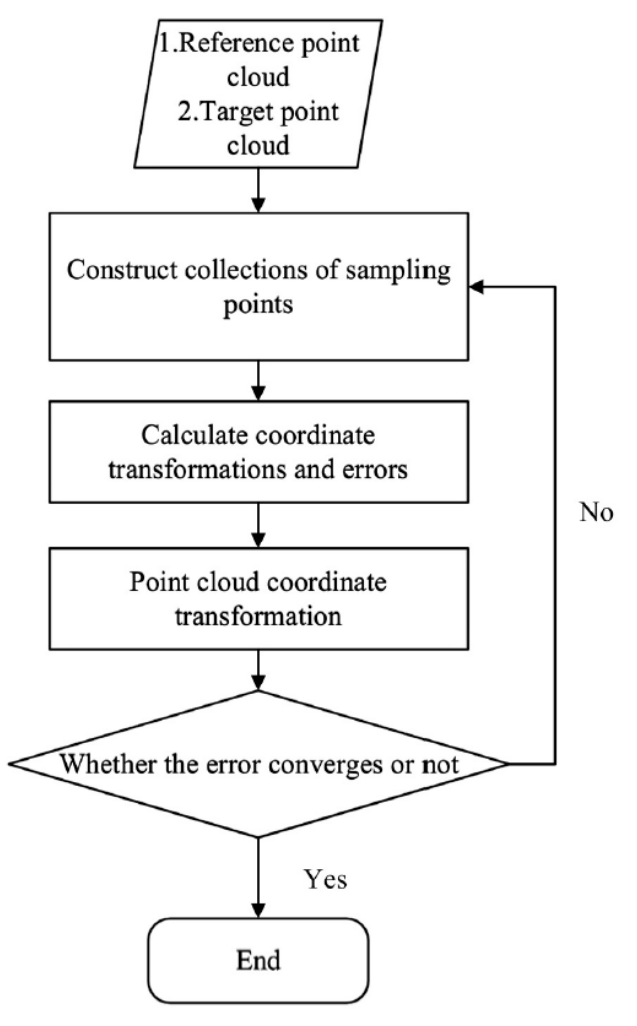
Figure 6. Process of performing alignment using the ICP algorithm.